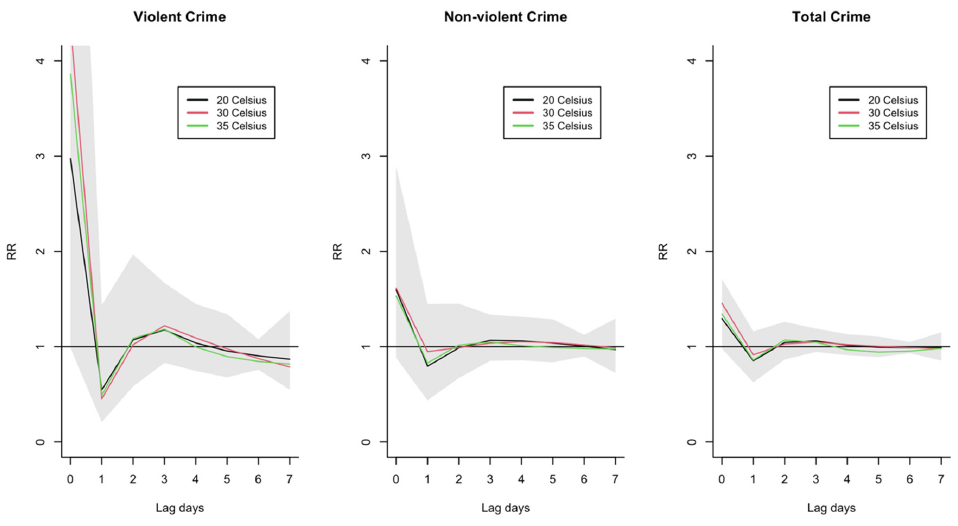
Figure 2. Individual lag–response curves for different temperatures (at 20 °C, 30 °C and 35 °C), reference 12 °C in urban Hanoi, Vietnam, 2013–2019. The models represent individual lag curves (from 0 to 7 days) and shaded areas denote 95% confidence intervals.